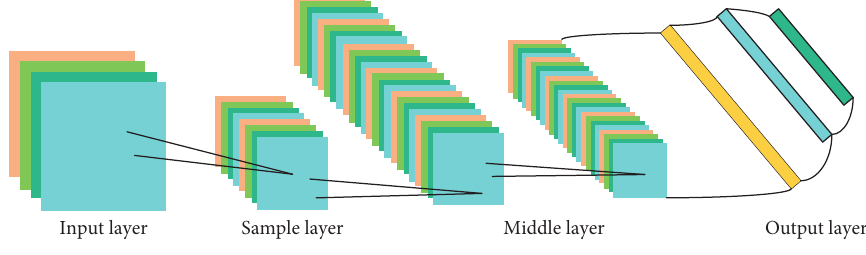
Figure 1: BP method